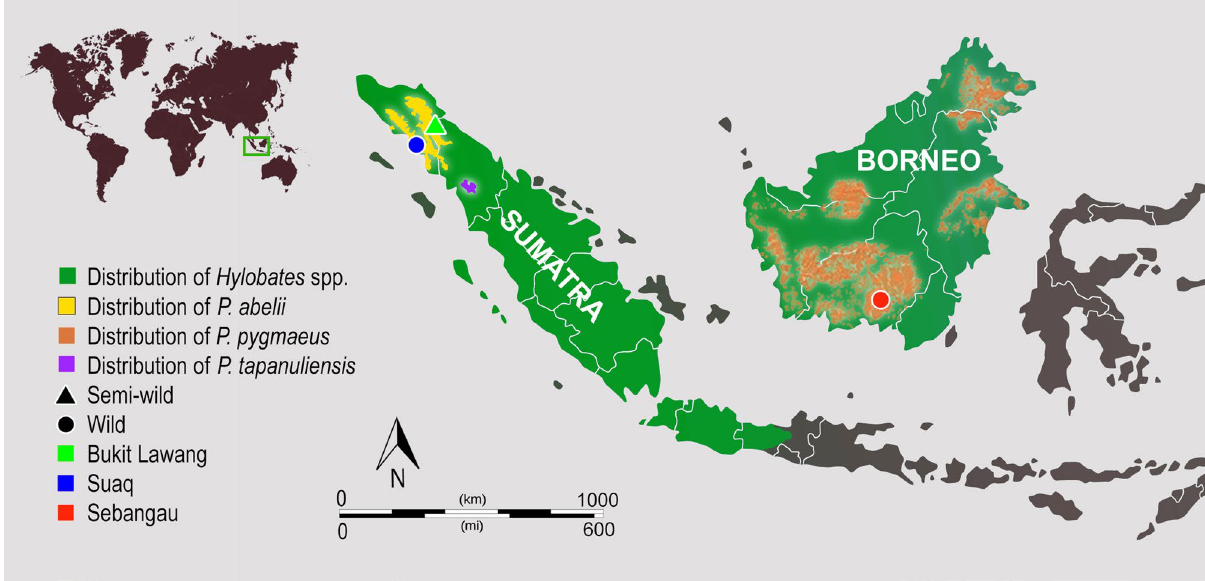
Figure 1. Geographical location of study sites in Borneo and Sumatra. For more information, please refer to Table 1 and Supporting Table S1. The map background was downloaded from free maps platform system (http:// www. freep ik. com) and modified in Adobe Photoshop